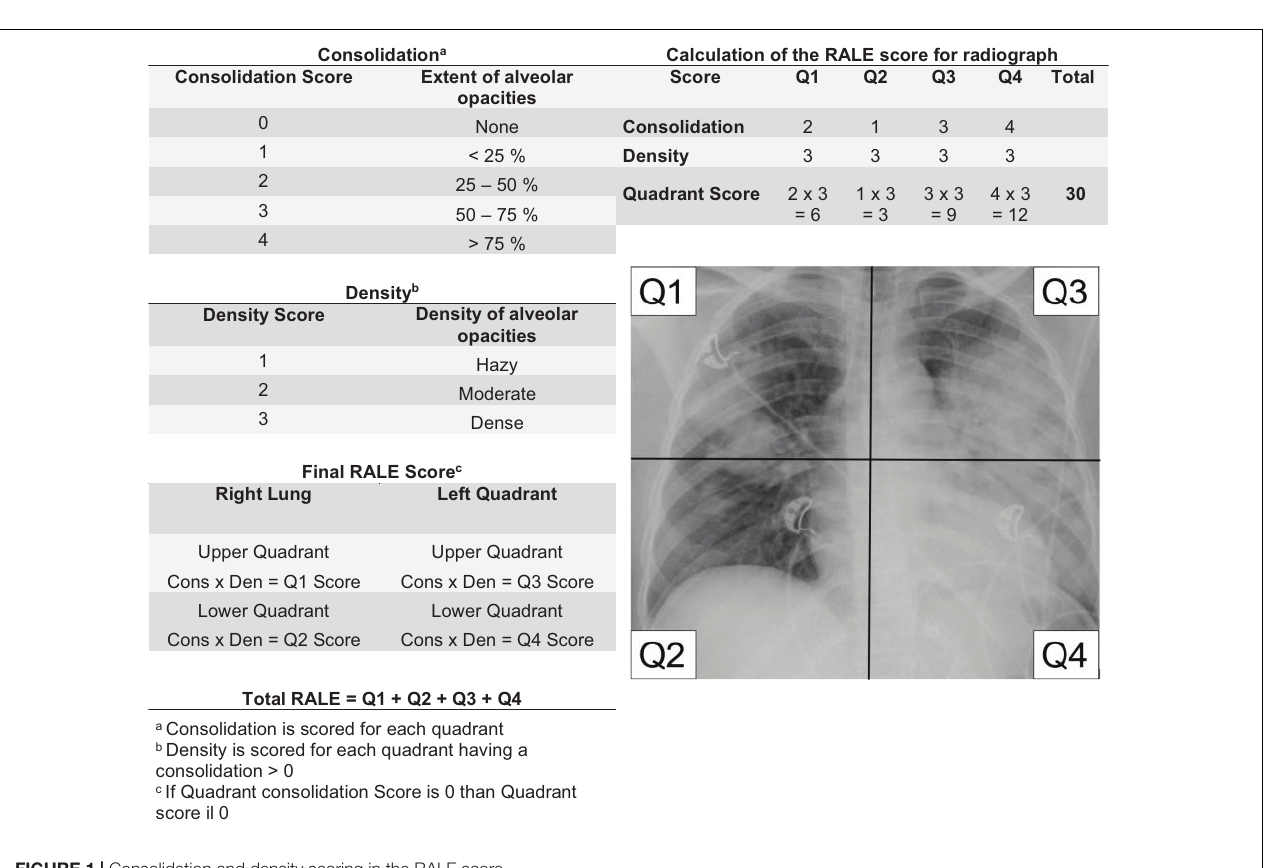
FIGURE 1 | Consolidation and density scoring in the RALE score.